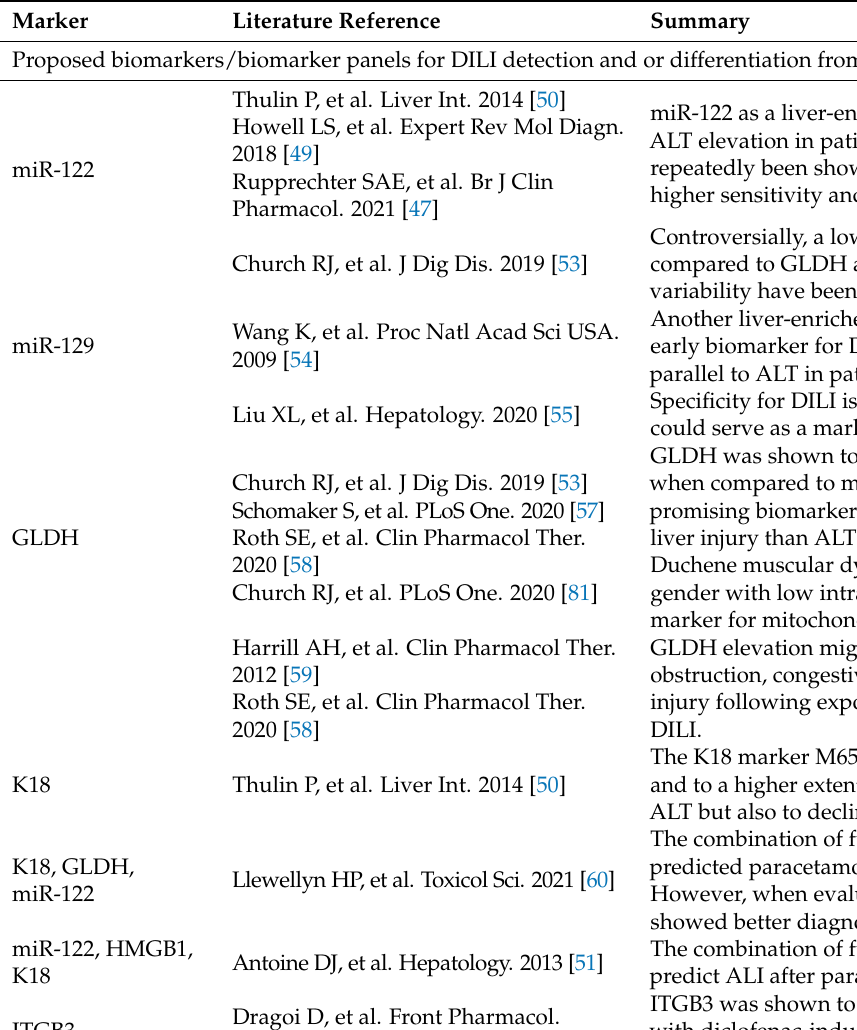
Table 2. Overview of diagnostic and prognostic biomarkers in drug-induced liver